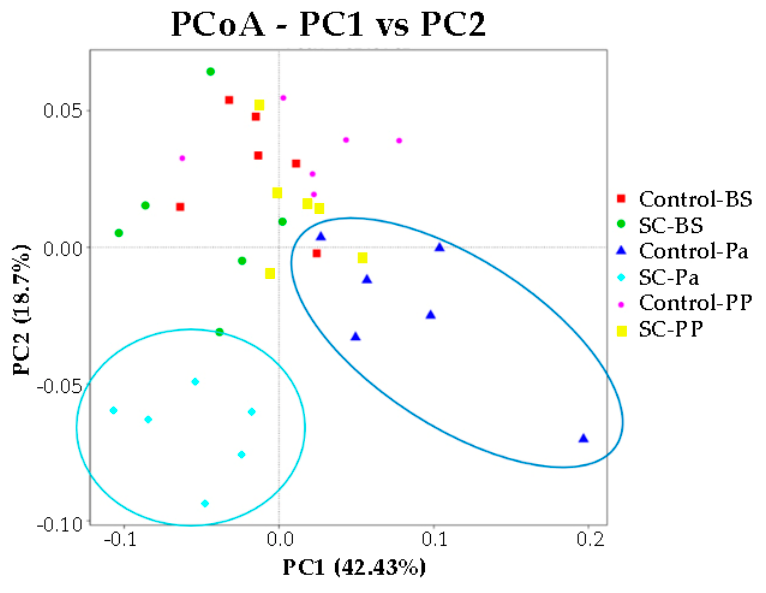
Figure 5. PCoA representation for the eukaryotic and fungal communities in the ruminal samples of the control and SC groups at BS, Pa, and